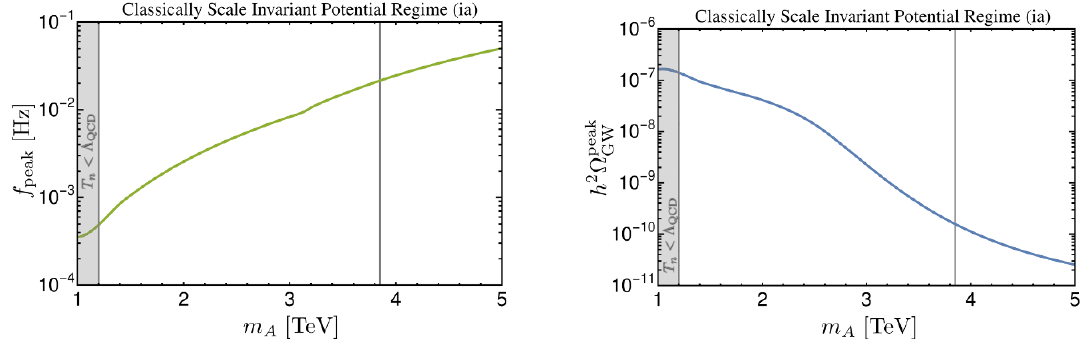
Figure 8 . Left: the peak frequency in regime (ia). Right: the gravitational wave amplitude at the peak frequency in regime